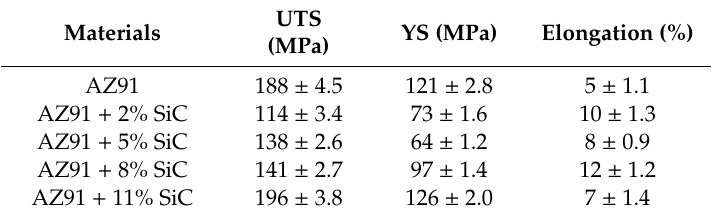
Table 4. The ultimate tensile strength and yield